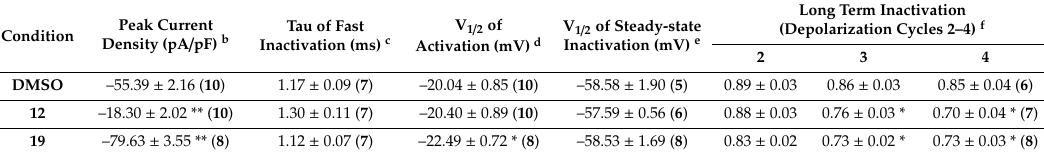
Table 4. Functional modulation of Nav1.6 by 12 and 19 relative to control a